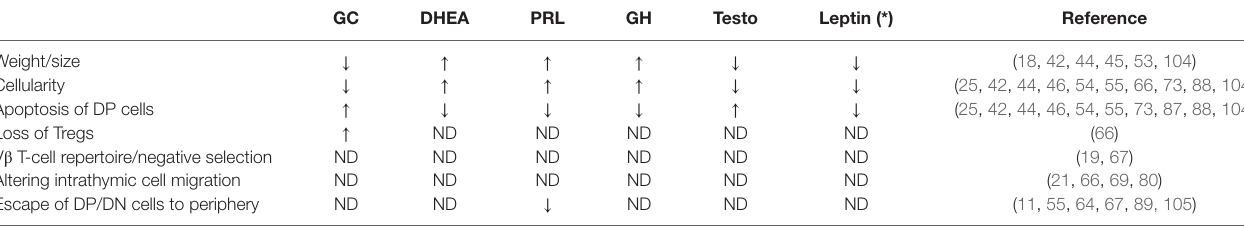
TABLe 1 | Effects of hormonal imbalance upon thymocytes during Trypanosoma cruzi